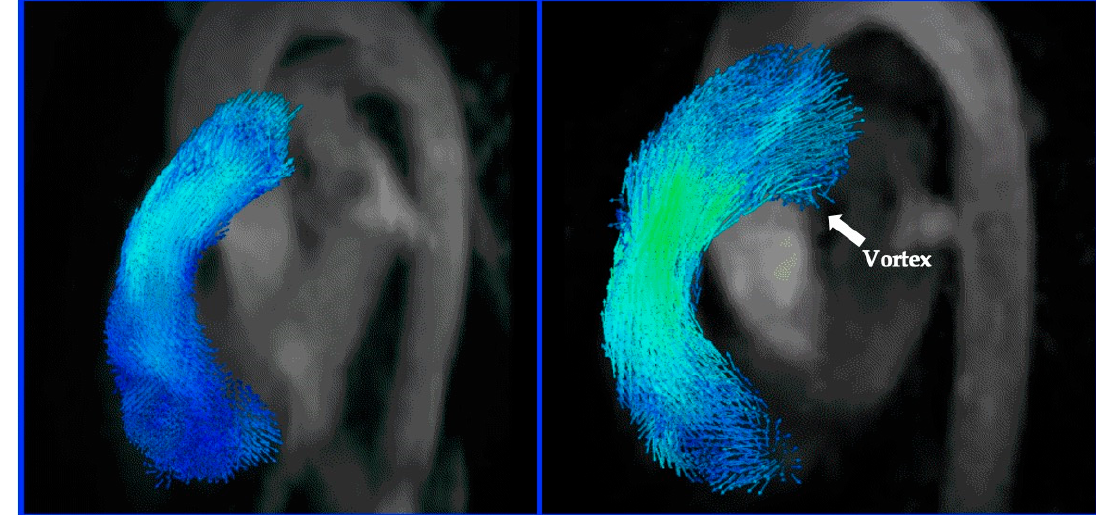
Figure 8. Also has corresponding Video (avi file 1). 4-D flow MR. Left panel: Normal flow. Right panel: Abnormal flow vortex (block arrow) in a patient with PH. There is a linear relationship between t vortex and mean pulmonary artery pressure (mPA) that allows for diagnosis of PH. Images courtesy of Dr Ursula Rieter, Department of Radiology, Medical University of Graz and Dr Gert Rieter, Research & Development, Siemens Healthineers, Graz, Austria.